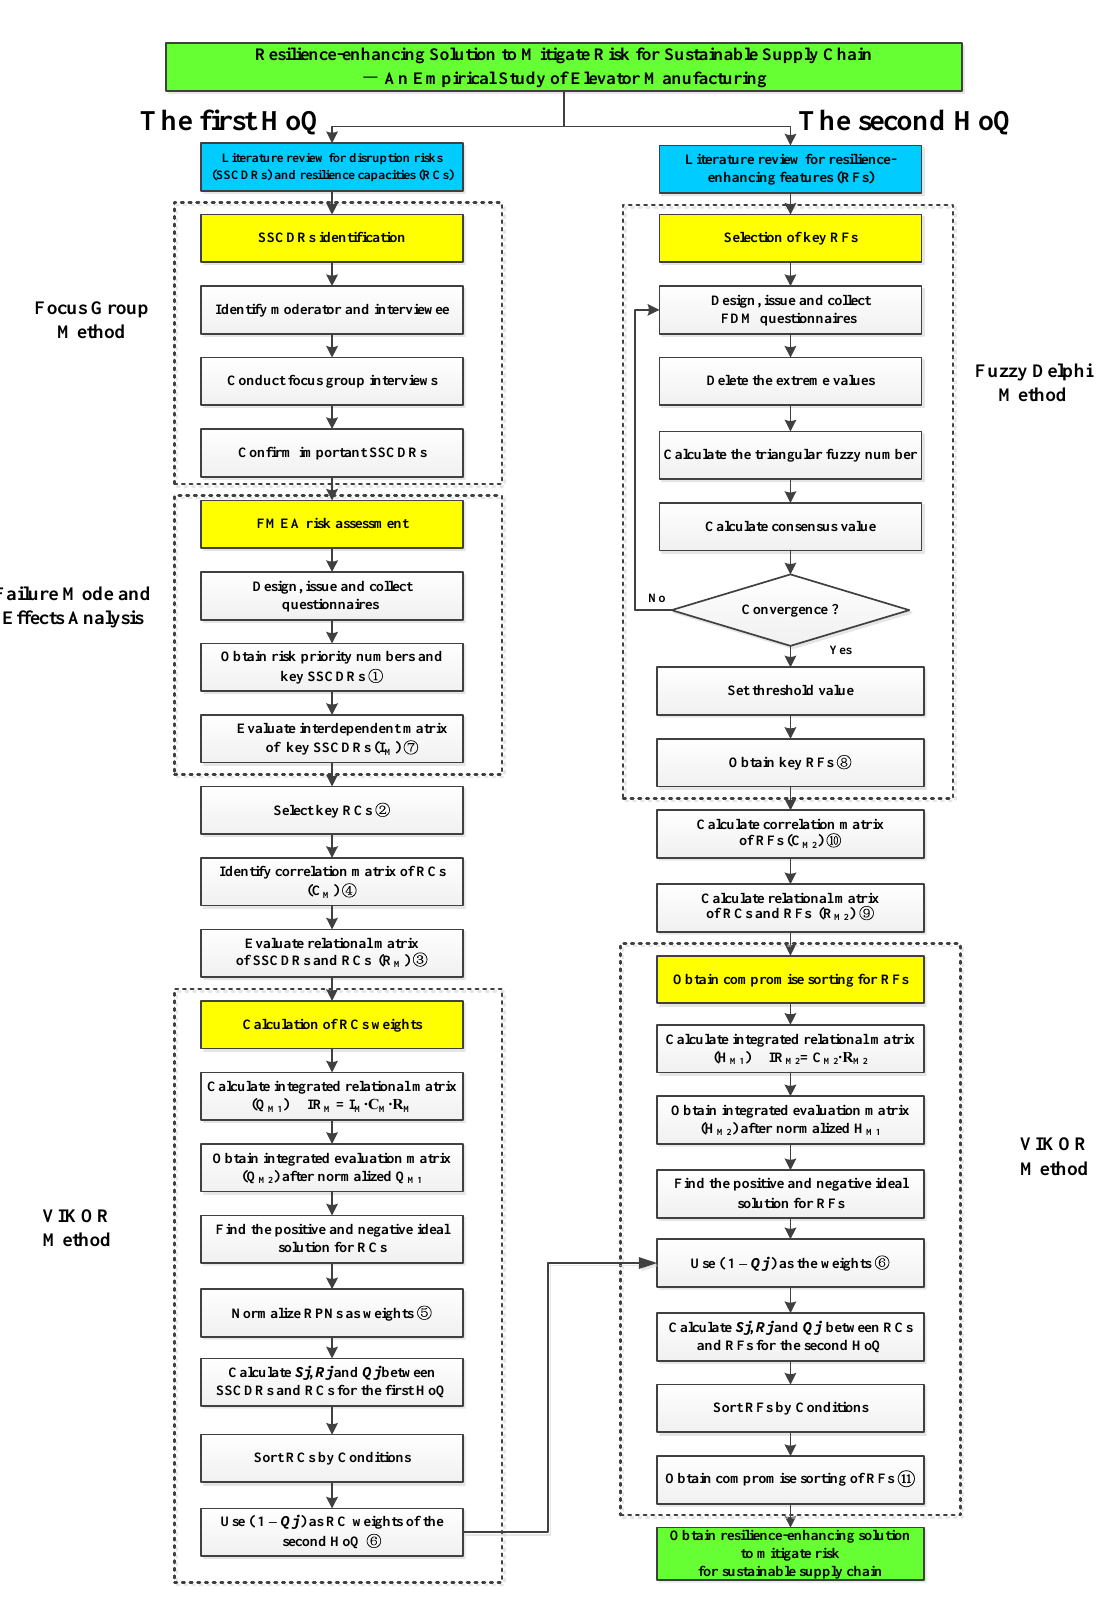
Figure 4. Proposed framework to build sustainable risk resilience for elevator manufacturing supply chains.